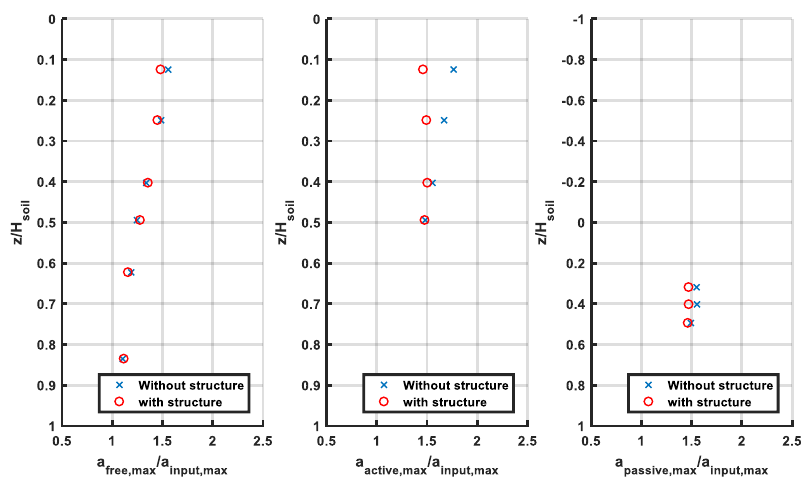
Figure 12. Amplification factor in the free-field, active and passive sides.